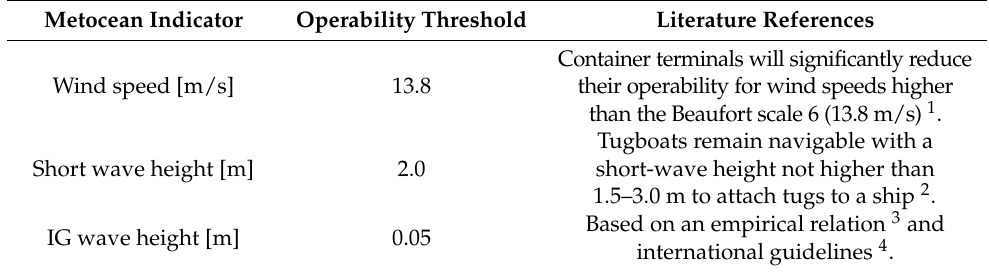
Table 1. Operability thresholds based on